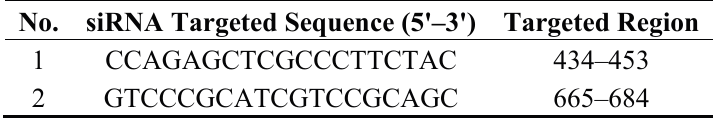
Table 2. Specific siRNA targeted region for human Clu